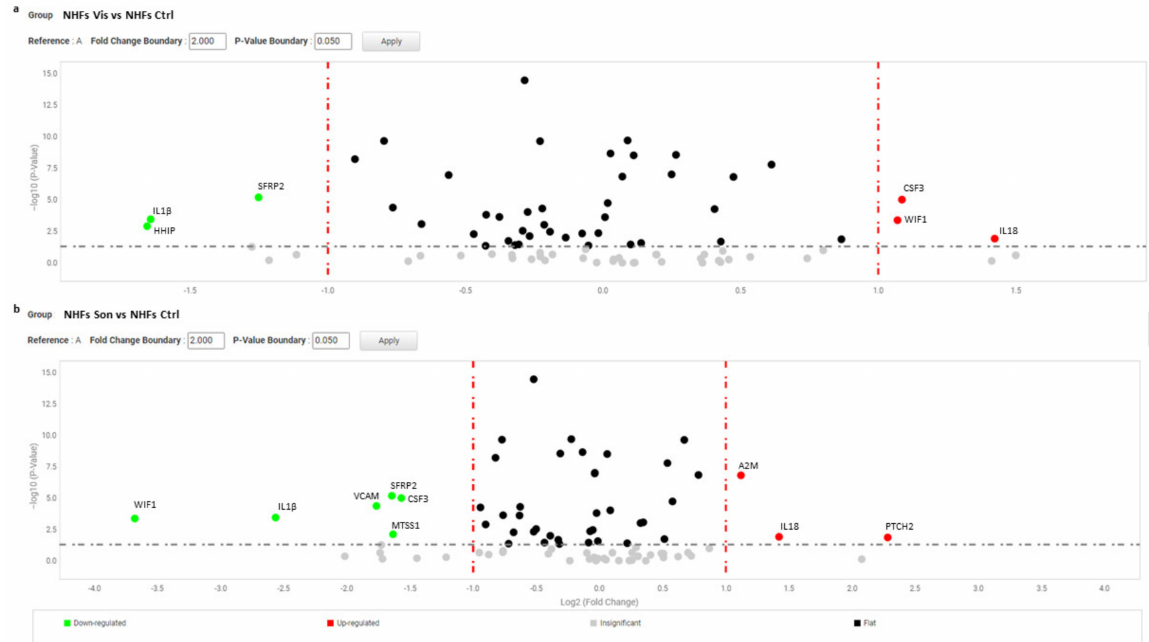
Figure 6. Volcano plot represents gene expression analysis comparing NHFs treated with vismodegib ( a ) and sonidegib ( b ) for 72 h (n = 9) to NHFs untreated (n = 9). ( b ) Analysis was performed using three different housekeeping genes ( β -actin, GAPDH and 18S). A one-way ANOVA statistical test with thresholds >2.0 fold-change and p < 0.05 defined significant increase are reported in red; significant decrease <0.5 fold-change and p < 0.05 reported in green; any fold-difference with p ≥ 0.5, e.g., insignificant are reported in grey; ≤ 2.0 or ≥ 0.5 difference e.g., flat reported in